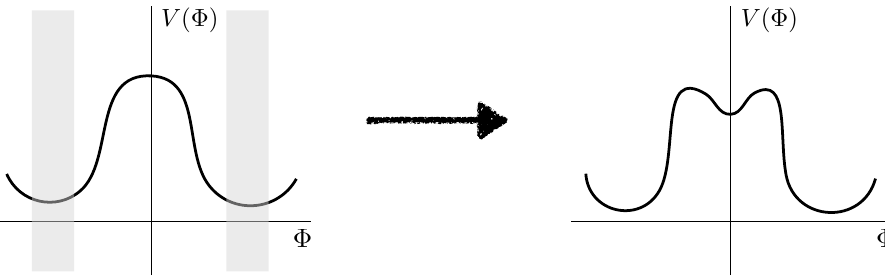
Figure 2 . On the left, we show the usual shape of the “Mexican hat” Higgs potential, which arises from equation (4.5). However, only the region shaded in gray has been accessed experimentally. It is conceivable that the region near Φ ≈ 0 has a different shape, for instance, that of the “cowboy hat” potential depicted in the right panel. As shown in the main text, such a scenario is incompatible with Festina Lente, unless extreme fine-tuning is carried